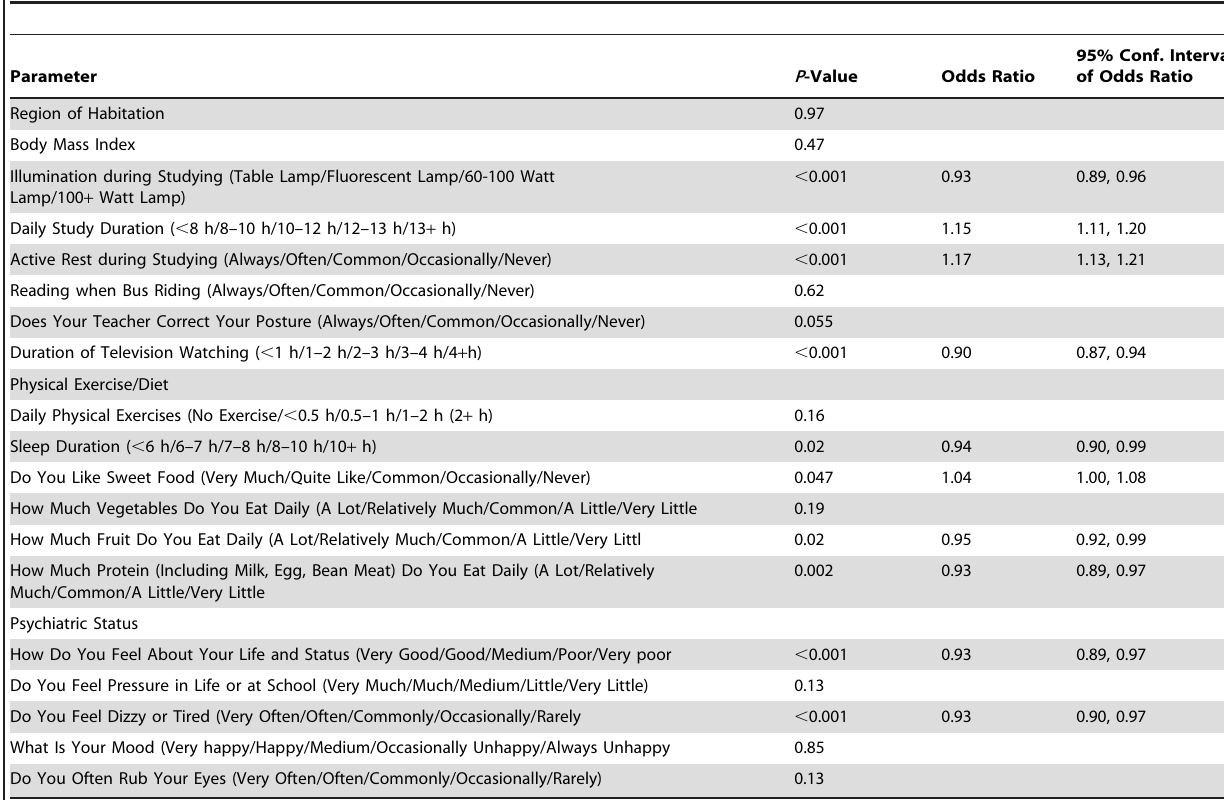
Table 2. Results of the multivariate analysis of the prevalence of myopia (defined as refractive error #2 1.00 diopters in the worse eye) and ocular and systemic parameters in the Beijing Pediatric Eye Study, after adjusting for age, gender, type of school, family income, and parental myopia, and adding step by step the following parameters.